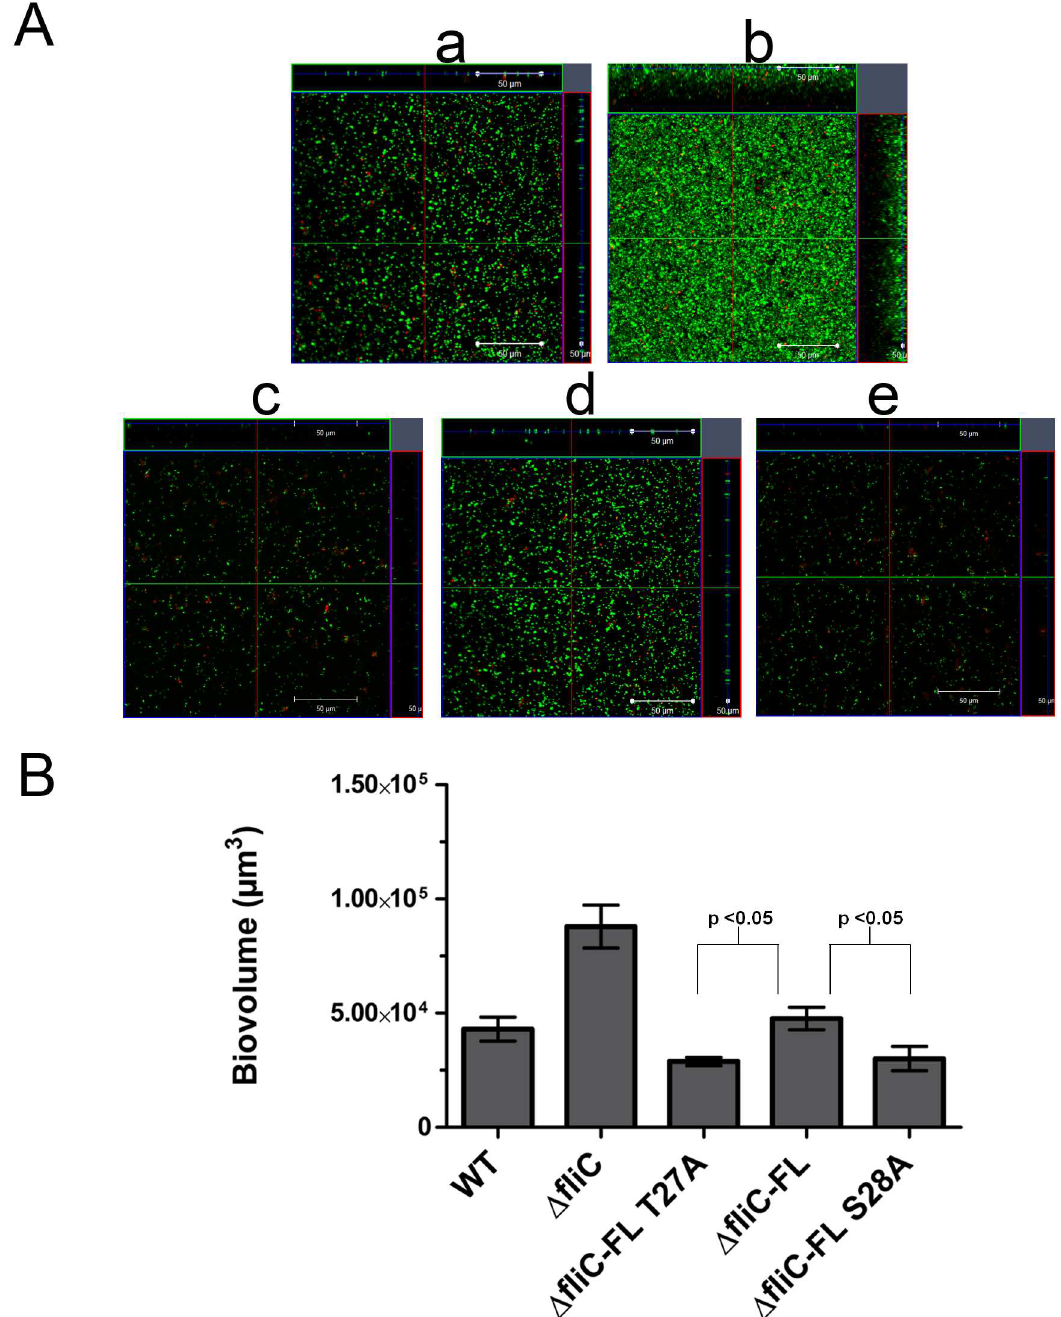
Fig 4. FliC phosphorylation affects static biofilm formation at 24 h. (A) Representative confocal-orthoview images of static biofilms of PAO1 WT, Δ fliC , Δ fliC -FL T27A, Δ fliC -FL and Δ fliC -FL S28A strains grown in 8 well chamber at 24 h. Live and dead cells are represented in green and red respectively. Panels are indicatedas a-WT, b- Δ fliC , c- Δ fliC —FL T27A, d- Δ fliC –FL and e- Δ fliC —FL S28A, respectively. Magnificationis under 40X oil lens. Scale bars indicate a distance of 50 μ m. (B) Biovolumesof WT, Δ fliC , Δ fliC -FL T27A, Δ fliC -FL and Δ fliC -FL S28A strains at 24 h. Error bars indicate mean ± SD computedfrom five biologicalreplicates. Student’s t-test p-values < 0.05 for Δ fliC -FL T27A vs. Δ fliC –FL and Δ fliC -FL S28A vs. Δ fliC